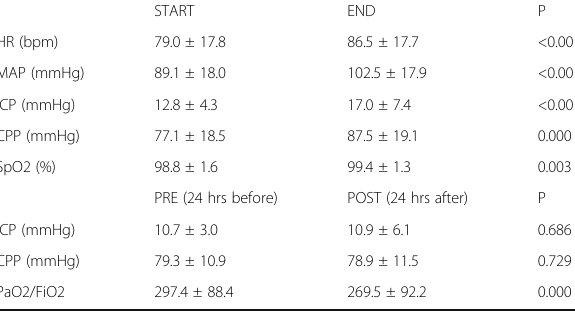
obstruction [1 (1%)] (needing urgent change without clinical conse- quences). Perioperative respiratory, hemodynamic and cerebral effects were reported in Table 1. Ninety-eight (94%) patients were discharged alive from ICU [median GCS 10 (IQR 8-11)]. Mean length of stay in ICU was 21.5 (± 10.8). Tracheostomy was present at discharge in 89 (85%) patients. CONCLUSIONS. Tracheostomy seems to be a safe procedure in ABI pa- tients. However, some complications (mainly intraoperative), requiring a rapid and appropriate management, may be present.